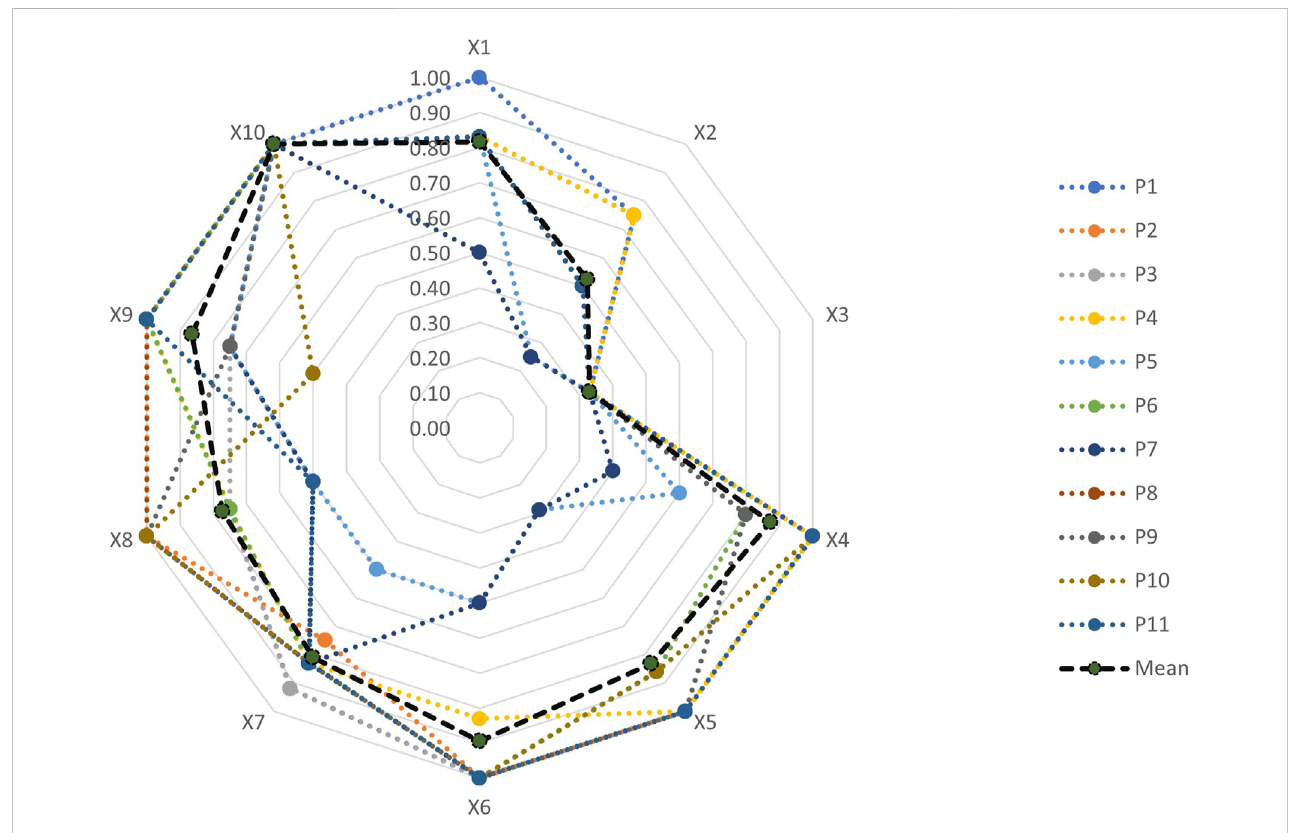
FIGURE 4 Radar chart of 11